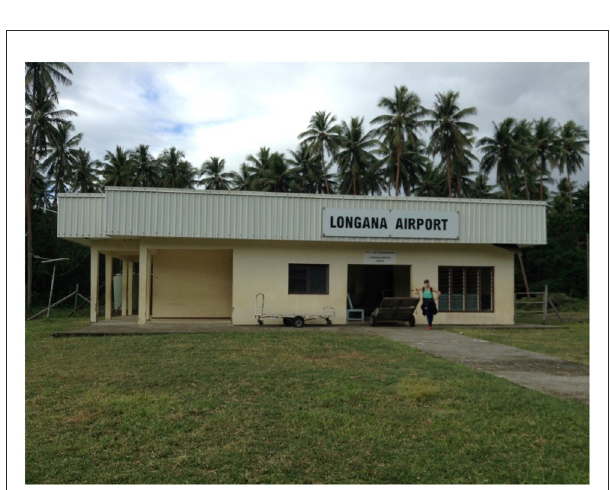
FIGURE3 Longana Airport, located in Northwest Ambae. Image source: Kelsey Dancause.